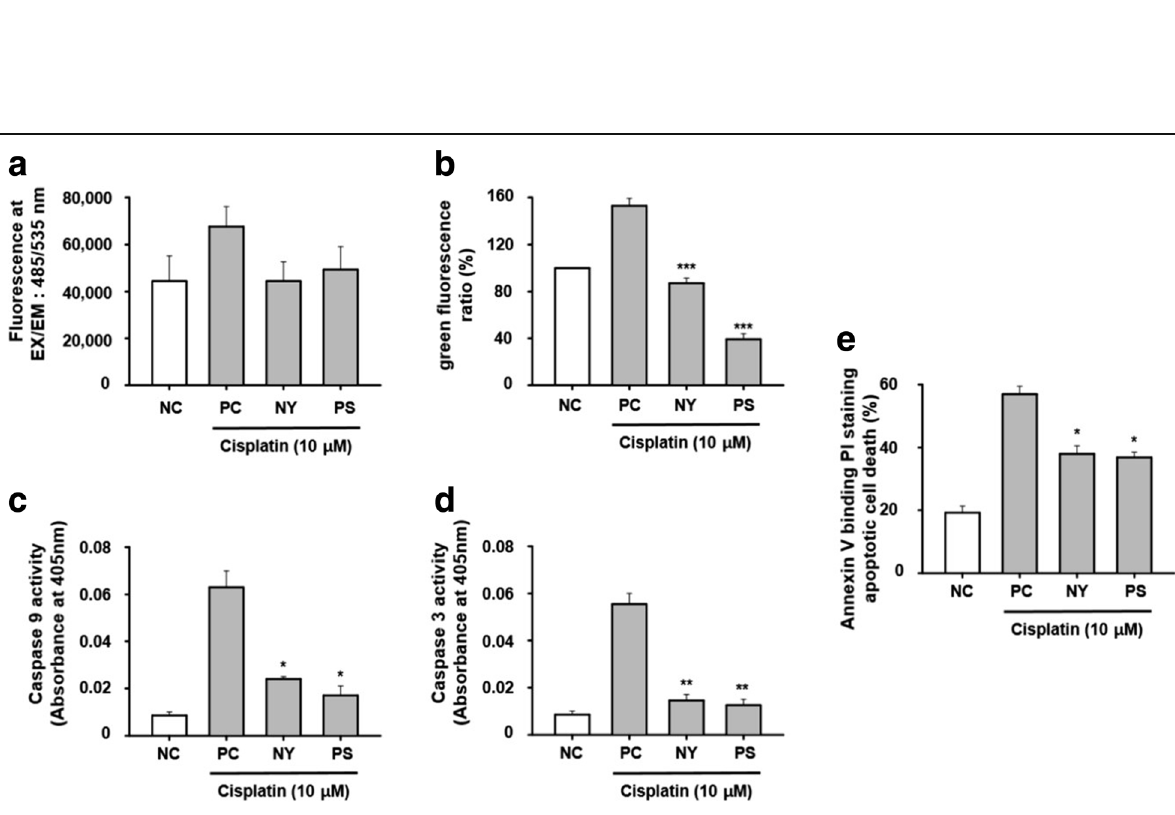
Fig. 5 Antioxidant effect of NY and PS on cisplatin-induced cell death in HK-2 cells. Cells were treated with 10 μ M cisplatin for 30 m and the level of ROS was detected by microplate reader ( a ). Cells were exposed to cisplatin for 24 h with or without PS or NY ( b ). The measures of JC-1 fluorescence in- tensity ( c and d ). Cells were treated to bind Annexin V and then to undergo PI staining; exposed to cisplatin for 24 h with or without PS or NY. HK-2 cells were treated with cisplatin for 24 h to measure apoptosis ( e ). Cell lysates were assayed for caspase-9, 3 activity. The statistical significance (* p <0.05, ** p <0.01 and *** p <0.001) of the observed differences between the cisplatin-treated and herbal groups was determined by a